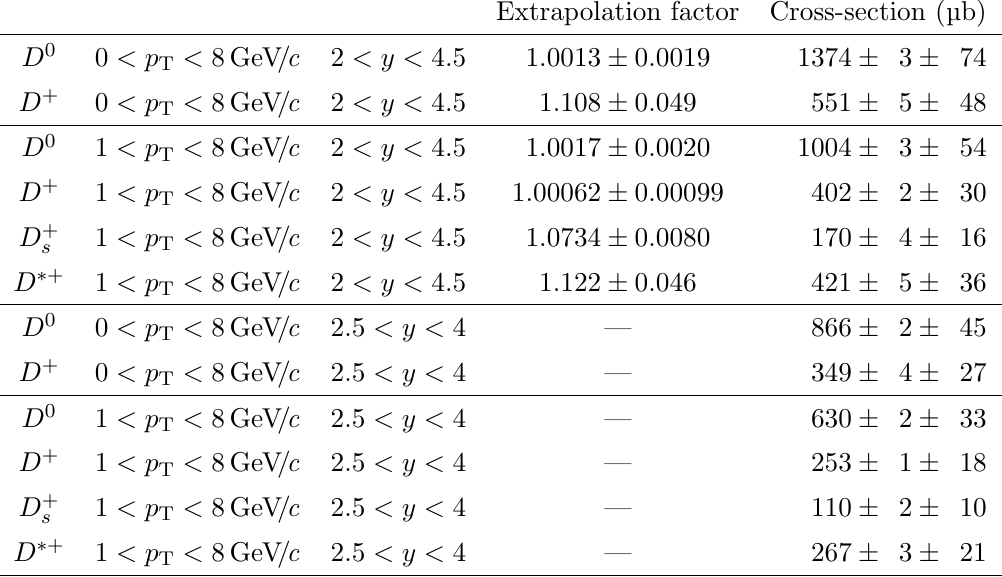
Table 3. Prompt D -meson production cross-sections in the kinematic ranges given. The computa- tion of the extrapolation factors is described in ref. [22]. The (cid:12)rst uncertainty on the cross-section is statistical, and the second is systematic and includes the contribution from the extrapolation factor. A dash indicates that measurements are available in all bins and no extrapolation factor